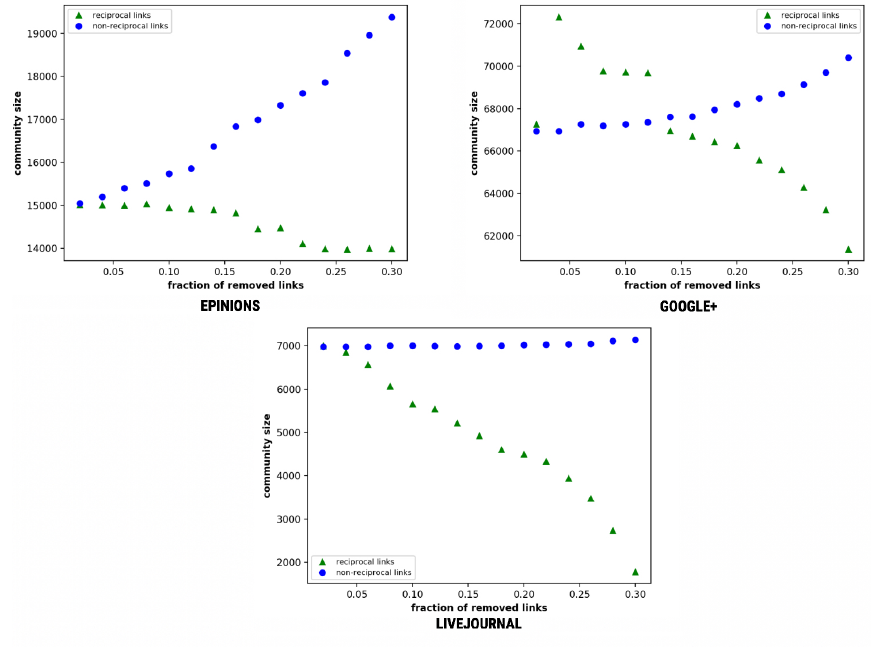
Figure 12. Affected community size as a function of the fraction of removed